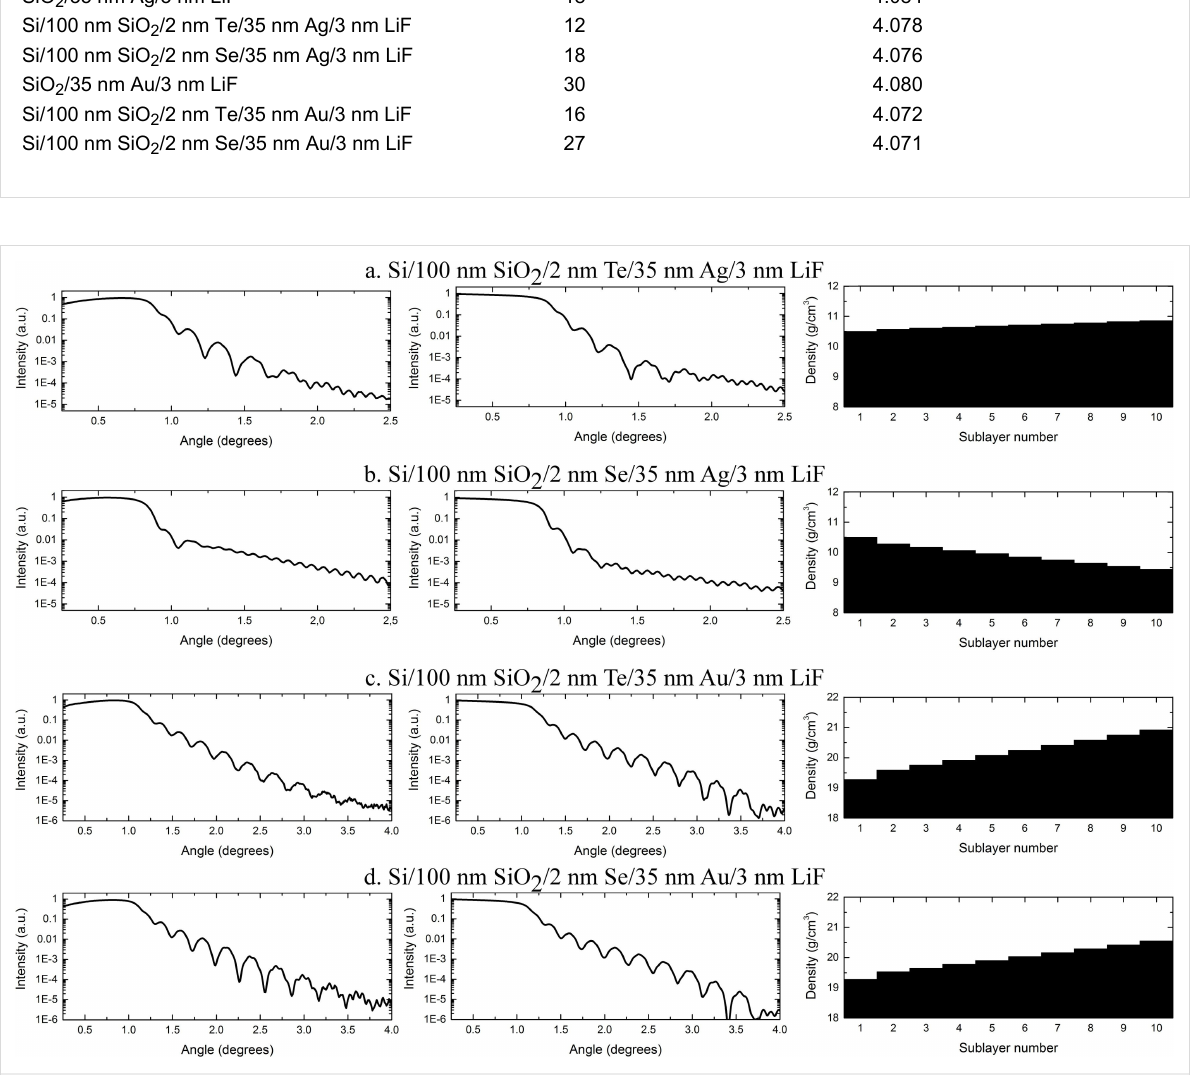
Figure 1: Measured XRR spectra (left column), fitted curves (middle column) as well as silver or gold layer density profiles extracted from the modeled curves (right column) for 35 nm-thick Ag or Au layers deposited on SiO 2 with 2 nm-thick Te or Se interlayers. The Ag and Au layers in the model were divided into ten sublayers and the density slope was set to exponential. Sublayer 1 is the one at the SiO 2 /metal interface, while sublayer 10 is the one at metal/LiF interface. The oscillations with the shortest period come from the 100 nm-thick SiO 2 substrate and are not related to the metal